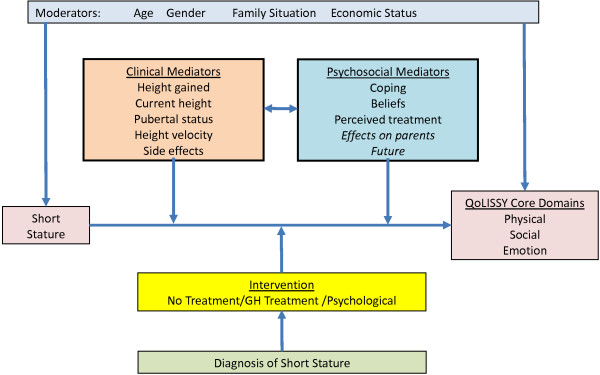
Conceptual model of the QoLISSY questionnaire.